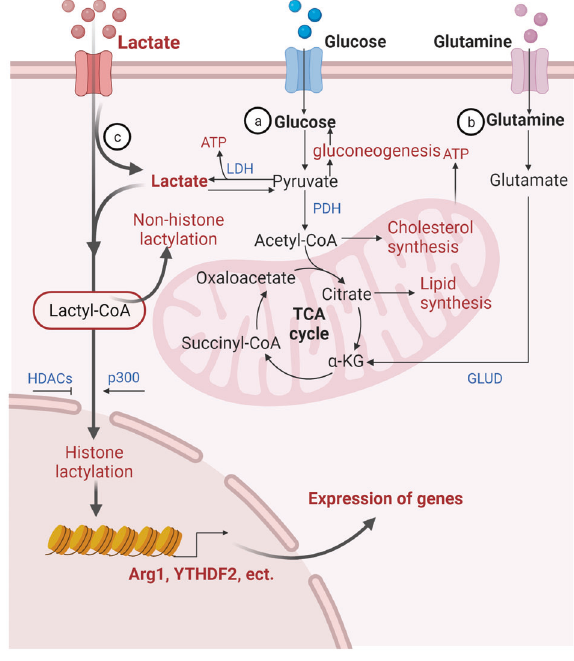
Fig. 1 Lactate metabolism and lactylation in cells. In the cytoplasm, lactate is transported into cells by MCTs and is produced from glycolysis or glutamine decomposition. The catabolism of lactate in cells occurs through two pathways. In one pathway, lactate is oxidized to pyruvate, which enters mitochondria and is metabolized through the tricarboxylic acid cycle. In the other pathway, lactate is converted to glucose through gluconeogenesis. Lactate can be converted into lactyl-CoA and is involved in the lactylation of histones and nonhistone proteins. LDH lactate dehydrogenase; PDH pyruvate dehydrogenase; GLUD glutamate dehydrogenase; HDACs Histone Deacetylases. (Figure was created with